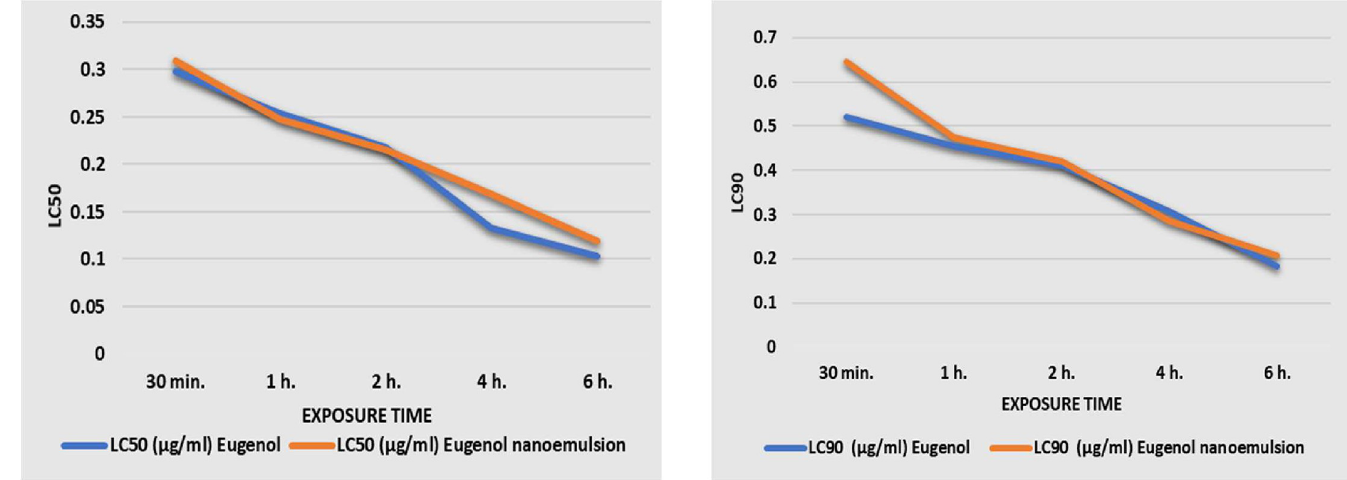
Fig 6. LC 50 and LC 90 of Eug and Eug-NE at different exposure periods.